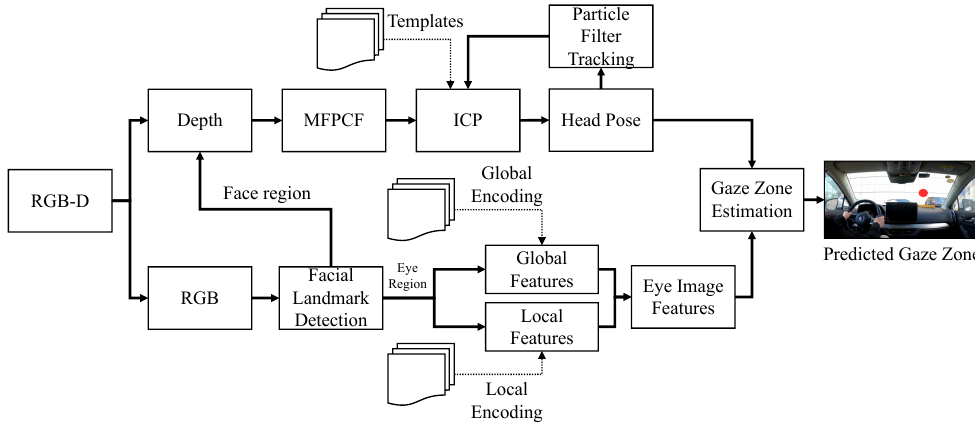
Figure 2. Overview of the proposed driver gaze zone estimation